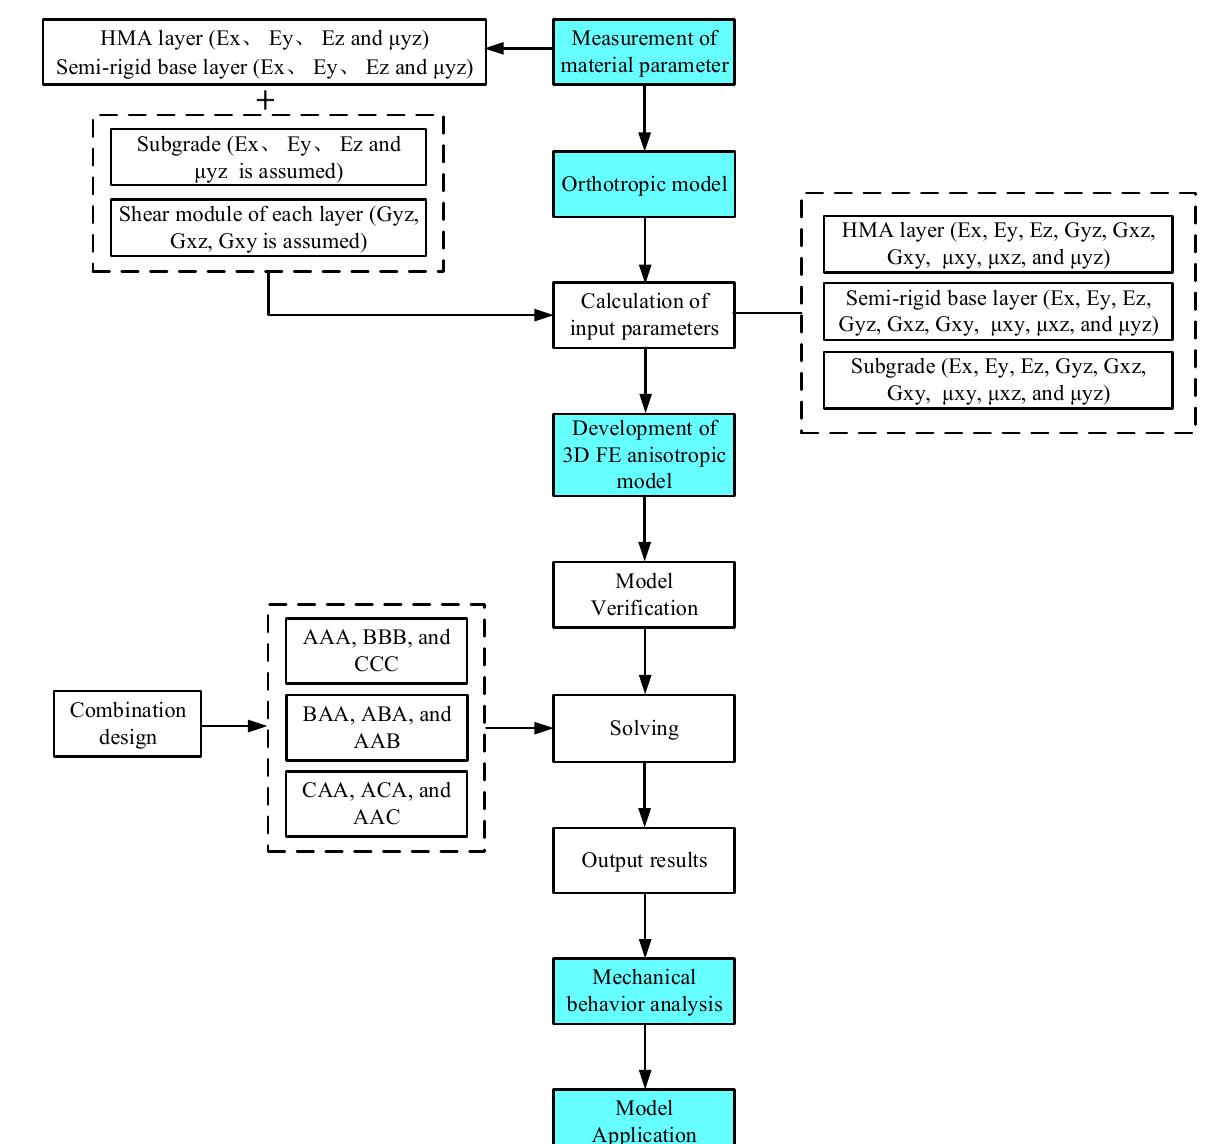
Figure 1. Our research methodology.